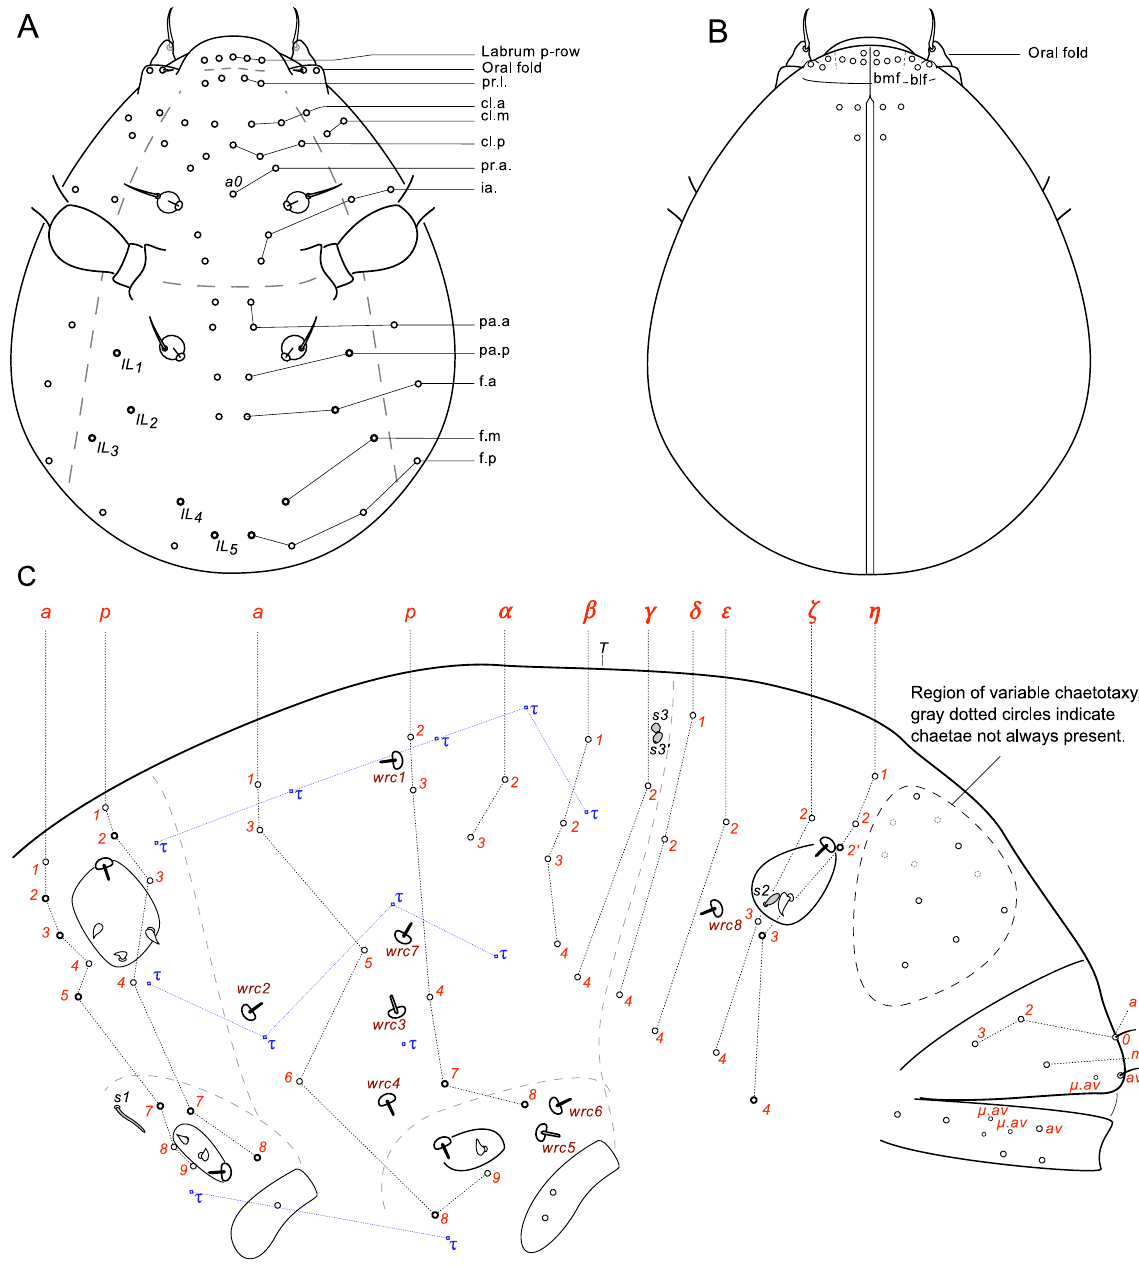
Fig. 7. Spinaethorax adamantis sp. nov. A–B . Diagram of the chaetotaxy of the head: A dorsal side, B ventral side. C . Diagram of the chaetotaxy of the trunk. Enlarged or lanceolate chaetae with thicker line. Nomenclature of chaetotaxy after Schneider & D’Haese (2013), Schneider et al. (2016) and Schneider (2017), partial equivalence with head nomenclature of S. tonoius (Palacios-Vargas & Sánchez 1999) is given in A ( IL1–5